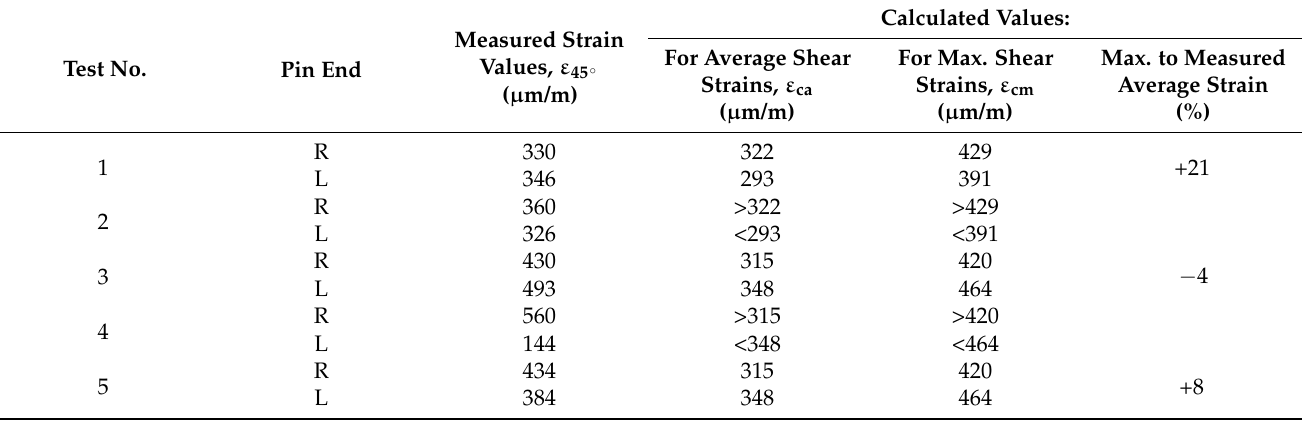
Table 4. Measured and calculated strain values at real cross-sections for 15 ◦ pin rotation and 500 kN external